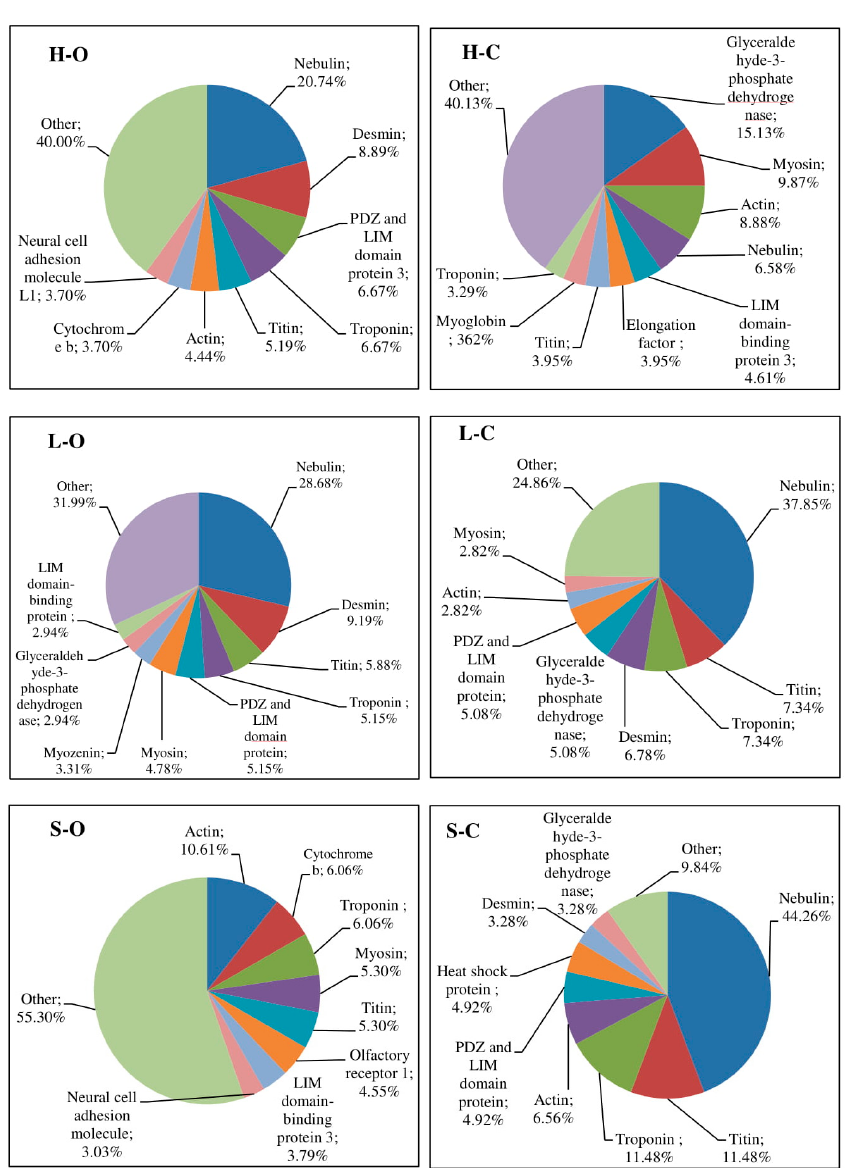
Figure 1. Distribution in percentages of identified peptides according to the origin of proteins in the analyzed muscle tissue (abbreviations: H-O: organic ham, L-O: organic loin, S-O: organic shoulder, H-C: conventional ham, L-C: conventional loin, S-C: conventional shoulder).